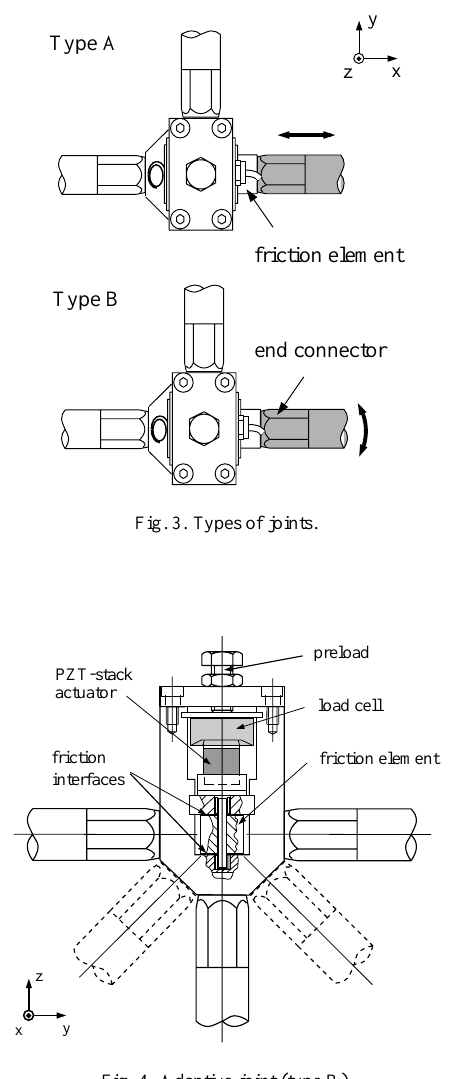
Fig. 4. Adaptive joint (type